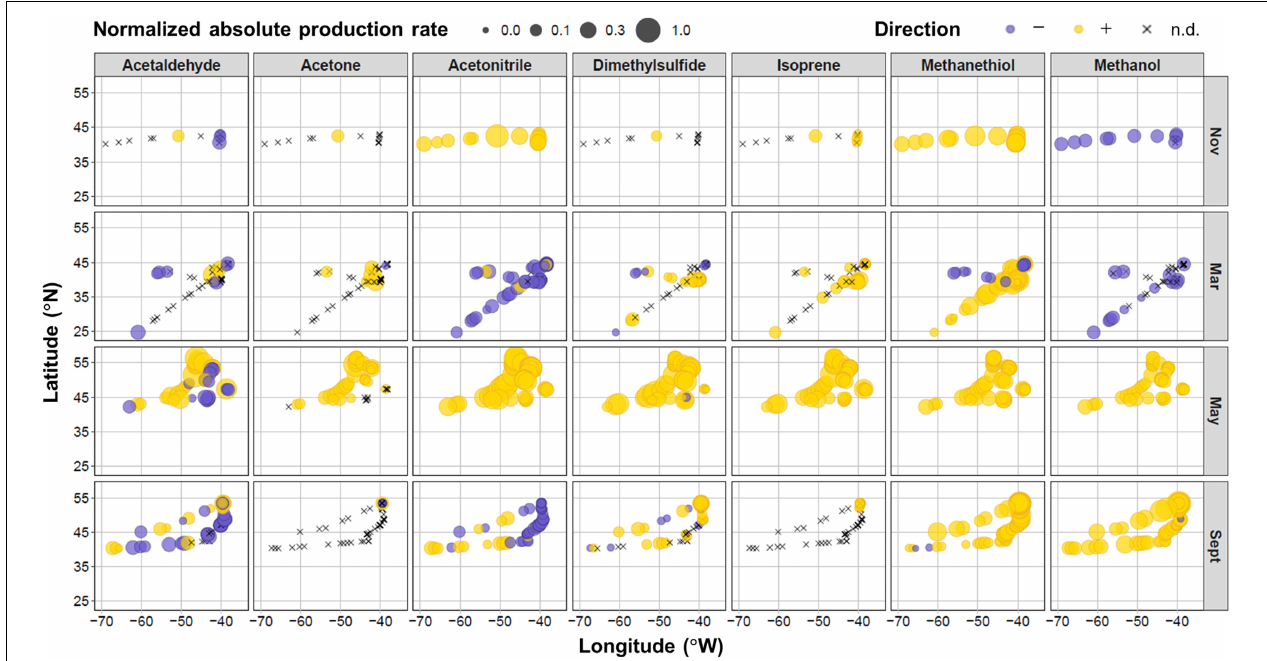
FIGURE 4 | Location of measurements and relative net production rates for target VOCs during the four field campaigns in the North Atlantic Ocean. Net production rates colored purple were negative, yellow were positive, or shown as black crosses when below the experimental limit of detection (n.d.). The size of the bubbles represents the absolute magnitude of the net production rate normalized to the maximum absolute net production rate for each VOC (which were 14.4, 80.2, 1.42, 43.3, 26.3, 7.86, and 859 nmol L − 1 h − 1 for acetaldehyde, acetone, acetonitrile, DMS, isoprene, methanethiol, and methanol,